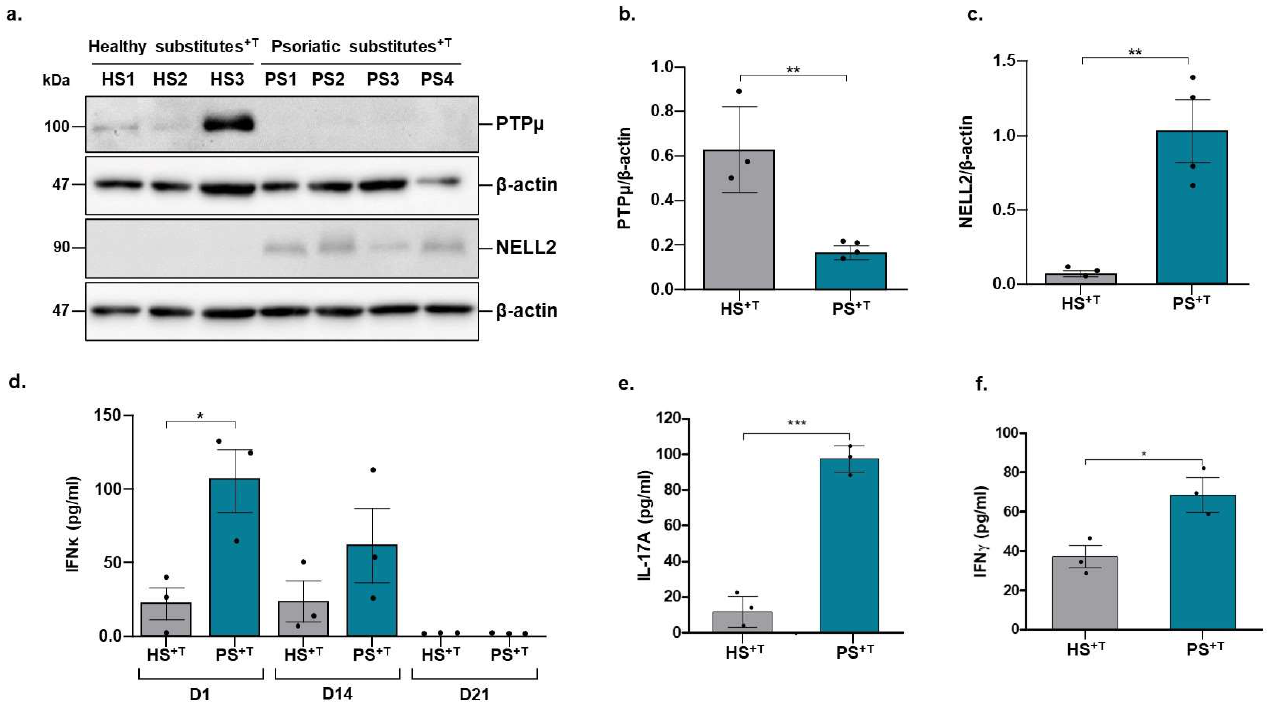
Figure 3. Differential expression of PTPµ, NELL2, IFN κ , IL-17A and IFN ƴ between healthy and psoriatic skin substitutes enriched with T cells. ( a ) Expression of PTPµ and NELL2 was monitored by Western blot analyses of total protein extracts prepared from the epidermal fraction of HS +T and PS +T (30 µg and 20 µg total protein, respectively, was loaded on a 10% reducing SDS-PAGE gel). Densitometric analysis of the immunoblots ( n = 3 healthy donors and 4 psoriatic patients) for the relative expression of ( b ) PTPµ and ( c ) NELL2. Β -actin is shown as a loading control. ( d ) IFN κ production in healthy and psoriatic skin substitutes enriched in T cells was measured by ELISA at days 1, 14 and 21 of air–liquid culture. Increase in IL-17A ( e ) and IFN ƴ ( f ) have also been validated at day 1 of air–liquid culture by ELISA assay. The p -values were derived from Student’s t-test and considered statistically significant when p ˂ 0.05. (* p ˂ 0.05, ** p ˂ 0.01, *** p ˂ 0.001, n = 3 donors per conditions). HS +T , healthy skin substitutes with T cells; PS +T , psoriatic skin substitutes with T cells; D, day.